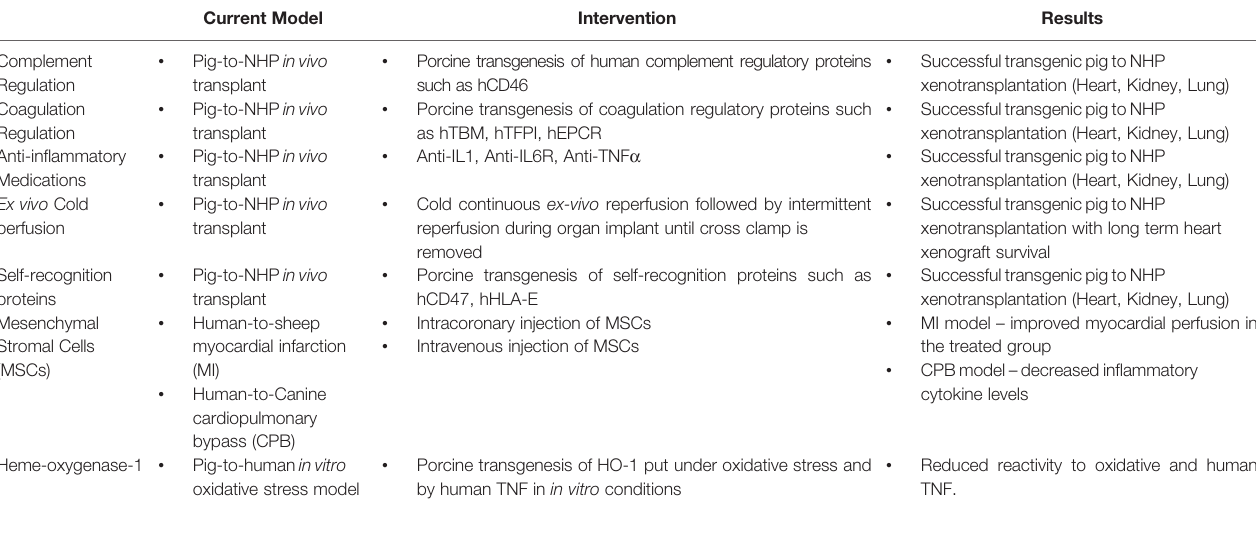
TABLE 2 | Summary of the promising mechanisms of ischemia reperfusion injury minimization currently being used in in vivo and in vitro models. Current Model